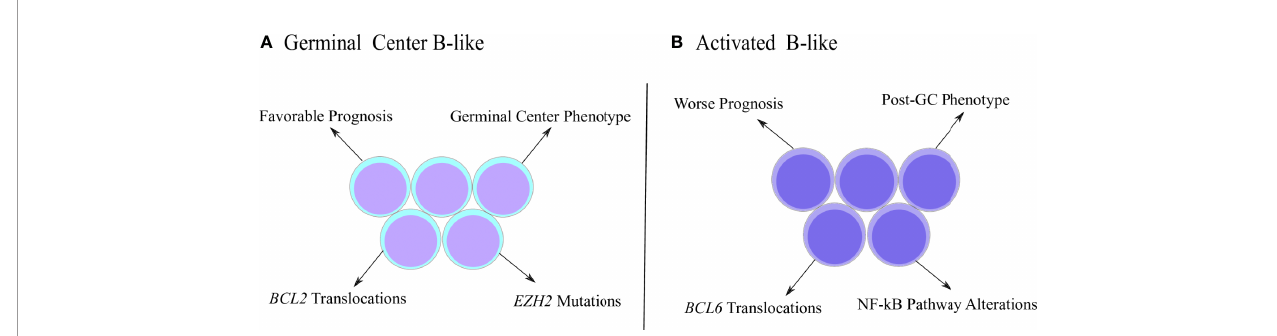
FIGURE 1 | Distinctive characteristics of DLBCL subtypes. (A) Germinal center B-like (GCB) subtype was originally characterized by a gene expression pattern that resembled the germinal center (GC) phenotype. GCB cases are associated with better prognosis, as well as molecular properties, such as increased frequency of BCL2 translocations and EZH2 mutations. (B) Activated B-like (ABC) subtype was described with a gene expression pattern associated with the post-GC phenotype. ABC subjects show worse prognosis and speci fi c molecular properties, such as higher frequency of BCL6 translocations and alterations involving the NF-kB